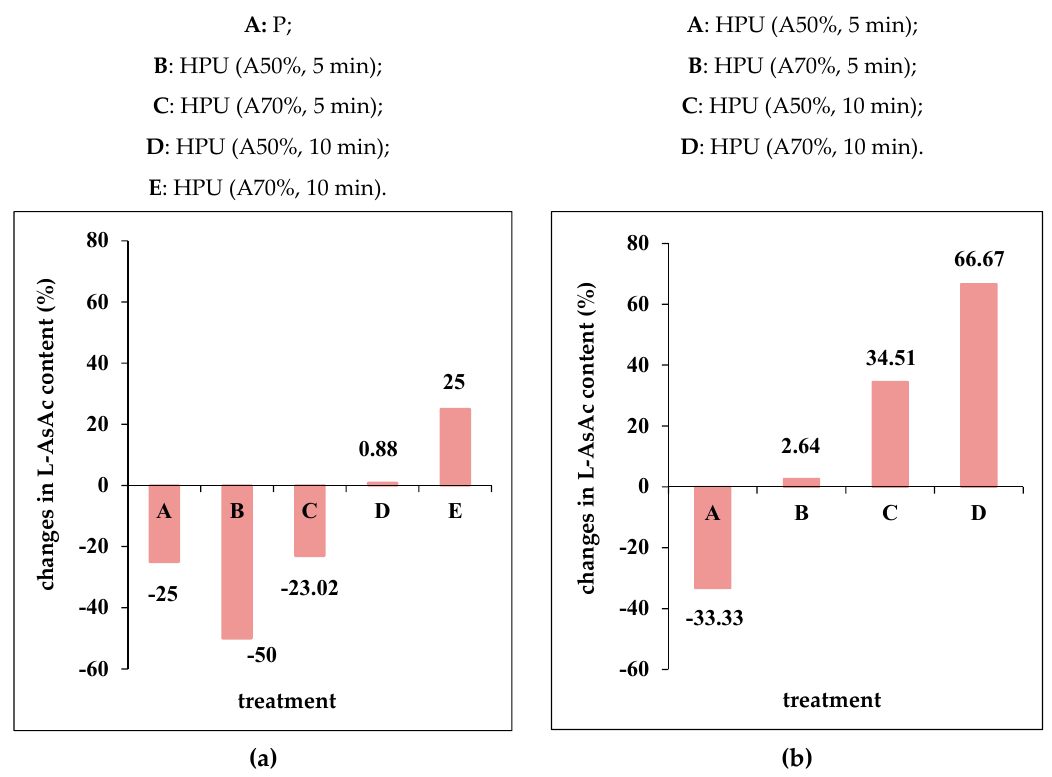
Figure 4. The changes in L -ascorbic acid (L-AsAc) content of juice samples in response to the applied treatments: ( a ) reported to the control sample (C); ( b ) reported to the pasteurized sample (P).